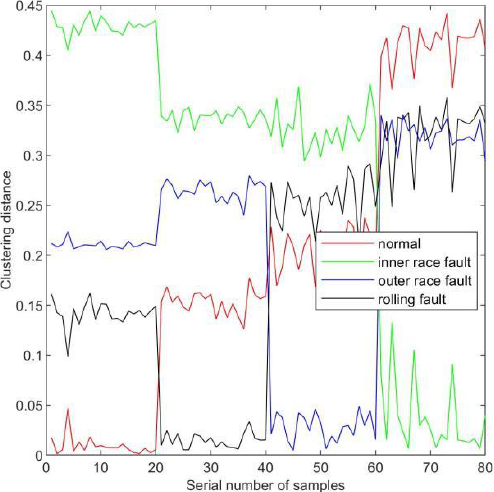
Figure 10. Distance between test set feature matrix and cluster center.